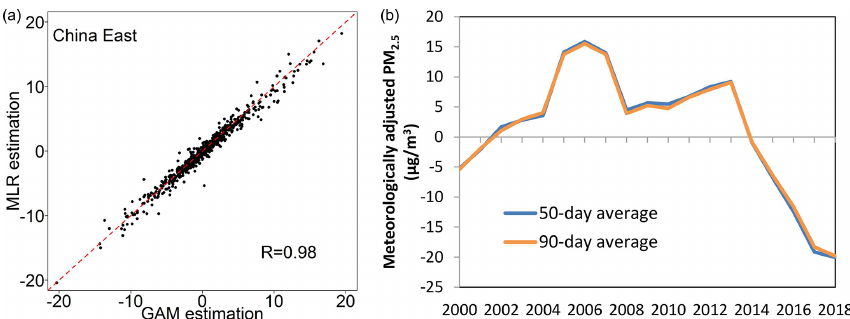
Figure A5. Meteorology-associated PM 2 . 5 variations estimated with the MLR and GAM (a) and meteorologically adjusted PM 2 . 5 with 50d seasonal averaging window and 90d seasonal averaging window (b)